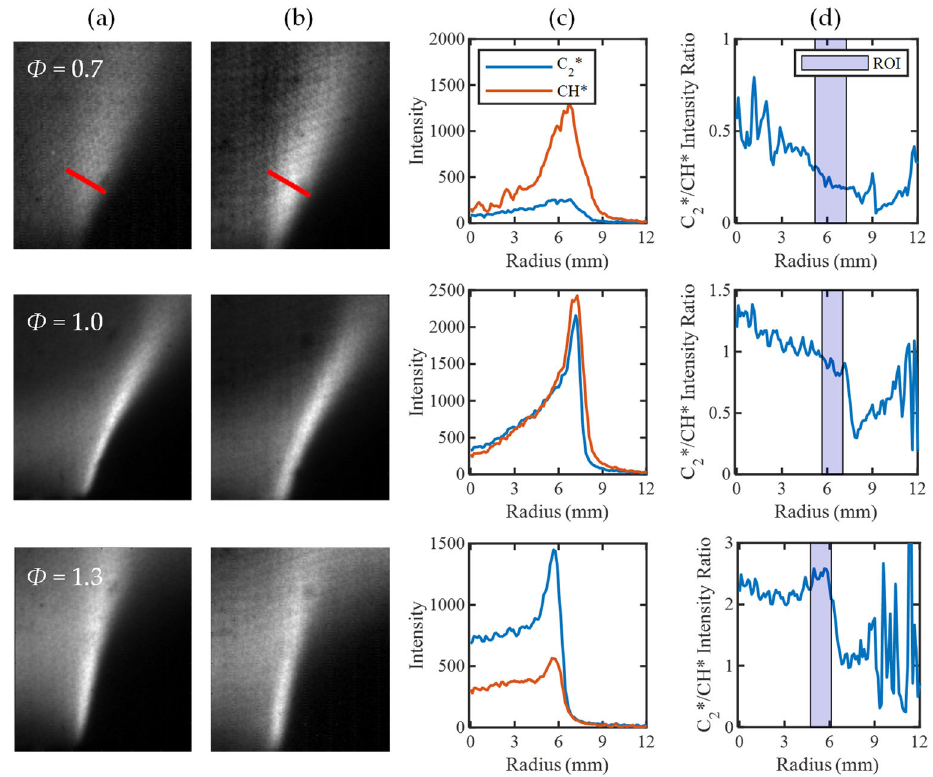
Figure 9. Chemiluminescent decomposition to assess the C2*/CH* intensity ratio in progress variable space, indicated by a red line in the Φ = 0.7 case. ( a ) C2* contour, ( b ) CH* contour, ( c ) C2* and CH* intensity profiles, and ( d ) C2*/CH* intensity ratio, ROI highlights thresholded flame region where calibration and mapping are completed.